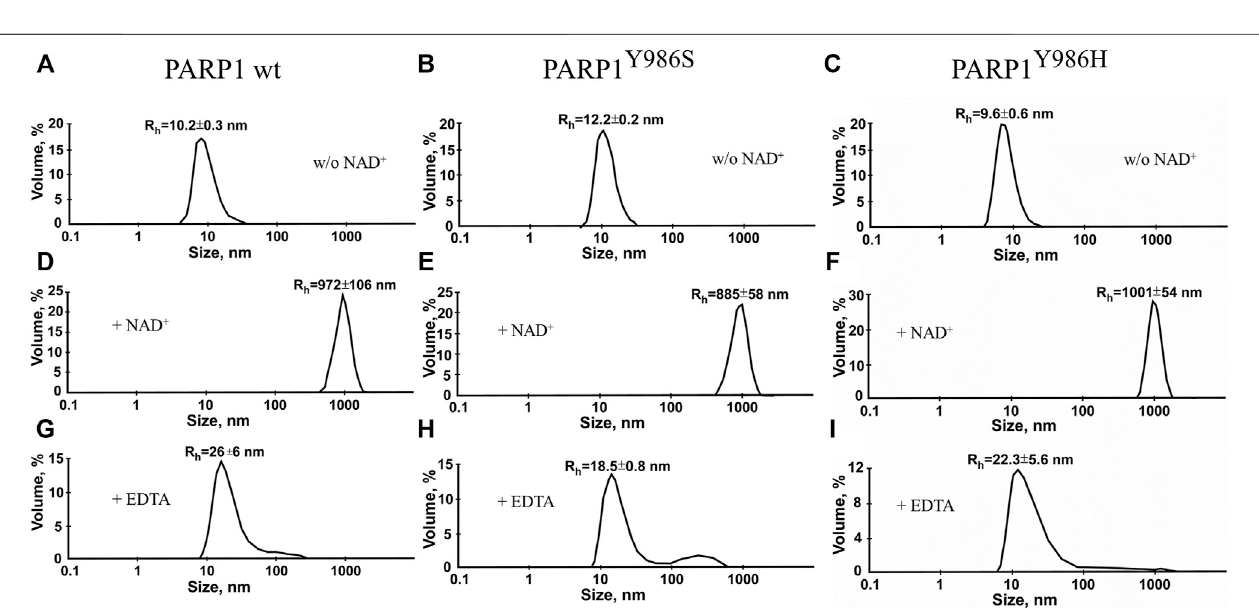
FIGURE7| Volume-weightedsizedistributionsofPARylatedPARP1wtanditsmutantsasdeterminedbyDLS.R h valuesweremeasuredforindividualproteins (A) immediately after 40-min incubation with NAD + and DNA (B) or after EDTA addition intended to disrupt aggregates of PARylated proteins stabilized with Mg 2+ (C). The reaction mixtures contained 2.5 μ M PARP1 or its mutant, 2.5 μ M DNA (Nick), 10 mM MgCl 2 and 1 mM NAD + (where indicated). Aggregation of autoPARylated PARP1 during PAR synthesis is mediated by Mg 2+ ions, which stabilize intermolecular contact between adjacent PARylated molecules (Vasil ’ eva et al., 2019). To disrupt automodi fi edPARP1assembliesstabilizedbyMg 2+ (B) EDTA(toa fi nalconcentrationof10 mM)wasaddedtodetecttherealsizeofPARylatedmolecules (C) .R h values are the mean (±SD) of three independent experiments.